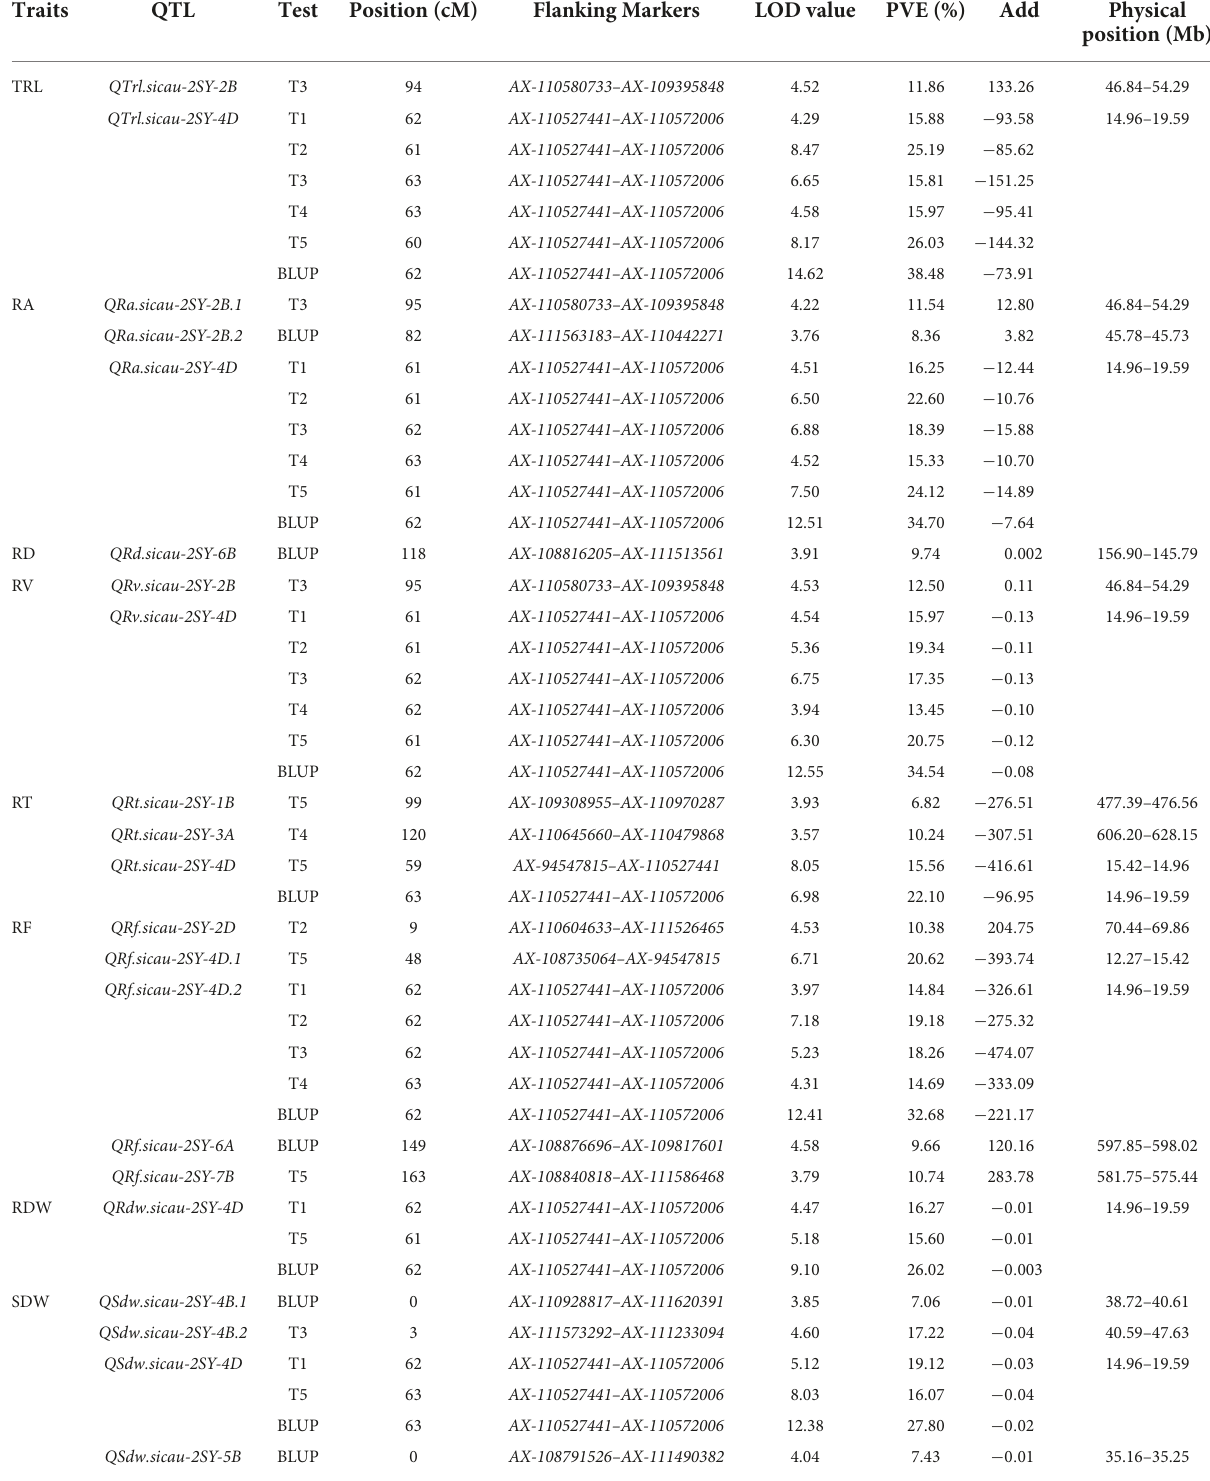
TABLE 3 Quantitative trait loci (QTL) for RSA-related traits identified from 5 independent tests.